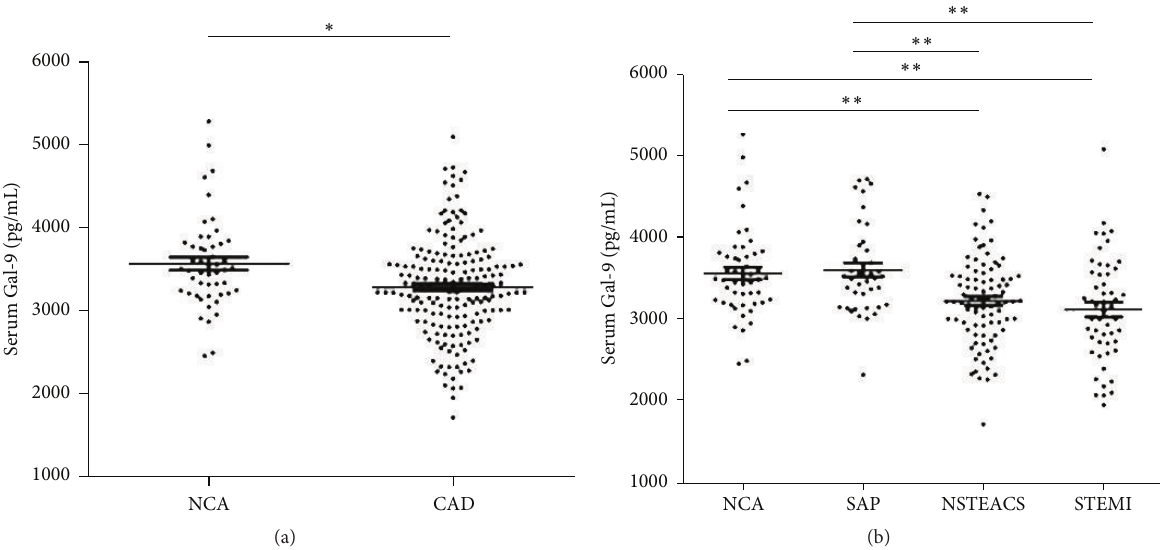
Figure 1: Serum Gal-9 levels in the four groups. (a) Compared with the NCA group, patients with CAD had significantly lower levels of Gal-9 (Figure 1(a)). (b) Serum Gal-9 levels were significantly lower in the STEMI and NSTEACS groups than those in the SAP group or the NCA group (Figure 1(b)). ∗ 𝑝 < 0.05 ; ∗∗ 𝑝 < 0.01 .